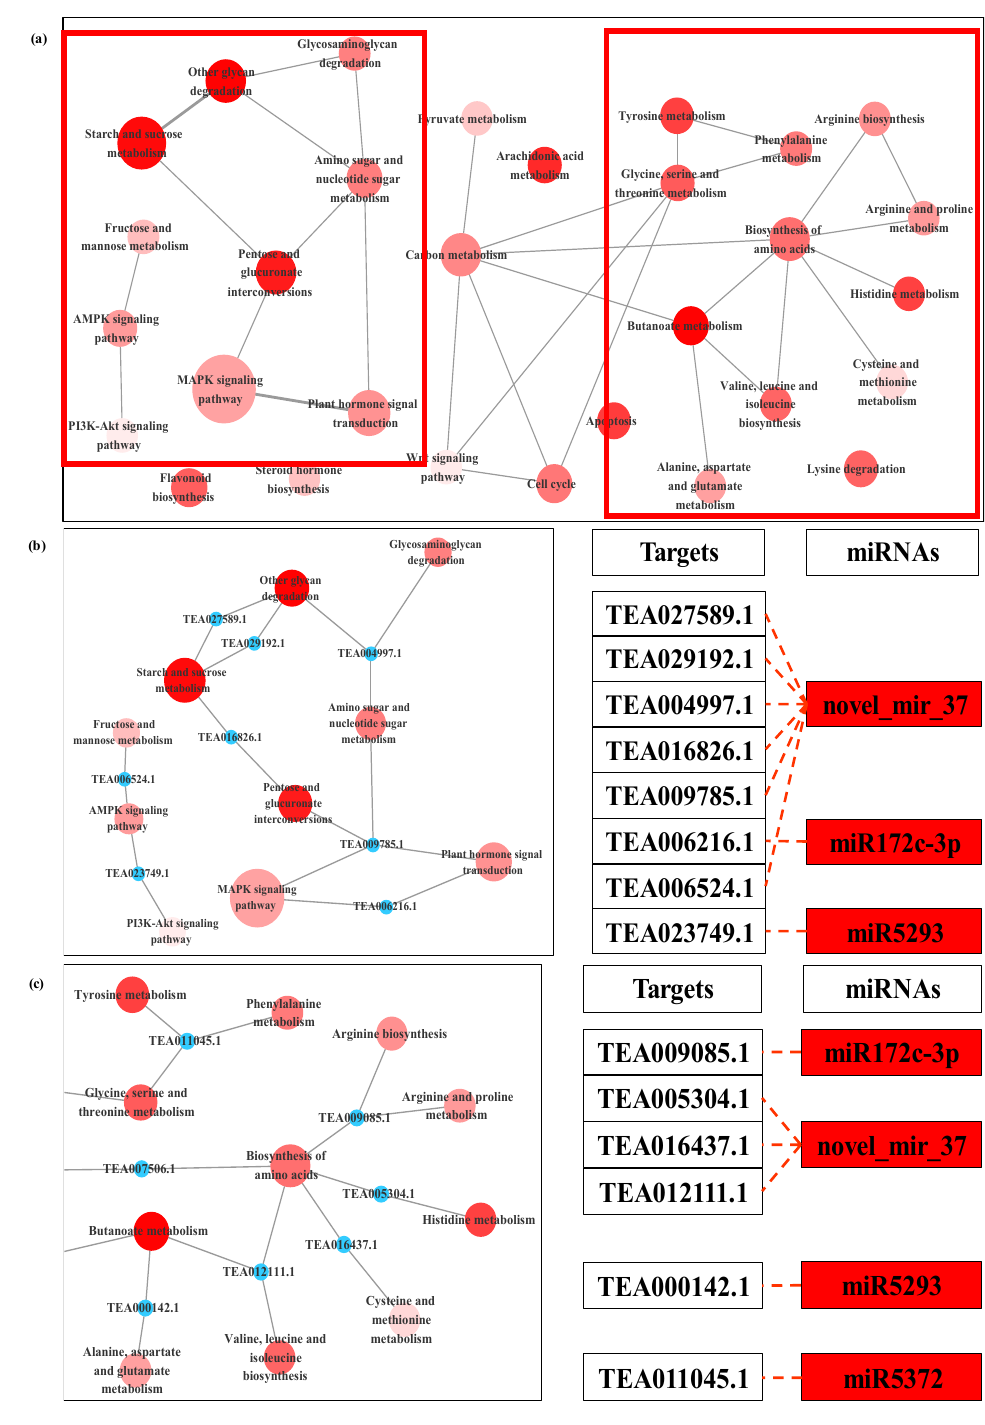
Figure 8. KEGG-KEGG network of the targeted genes of DEMs between NO (nitric oxide) and CK (control) ( a ). Local amplification of KEGG-KEGG network related to starch and sucrose metabolism and its miRNA target ( b ). Local amplification of KEGG-KEGG network related to biosynthesis of amino acids and its miRNA target ( c ). The filling color of the KEGG term from white to red represents the enrichment degree (p.adjust) of the KEGG term. Red miRNA term represents that miRNA is up-regulated in NO, and blue represents that miRNA is down-regulated in NO.